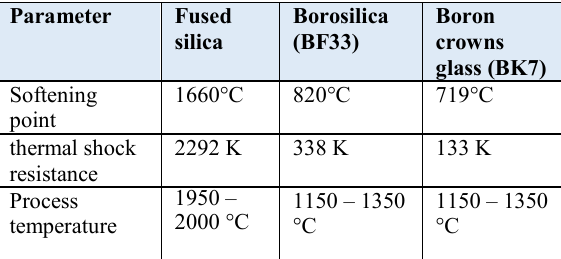
Table 1. Relevant material parameters for laser